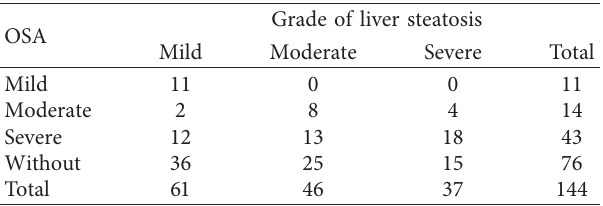
Table 3: Distribution of steatosis severity among groups with different levels of